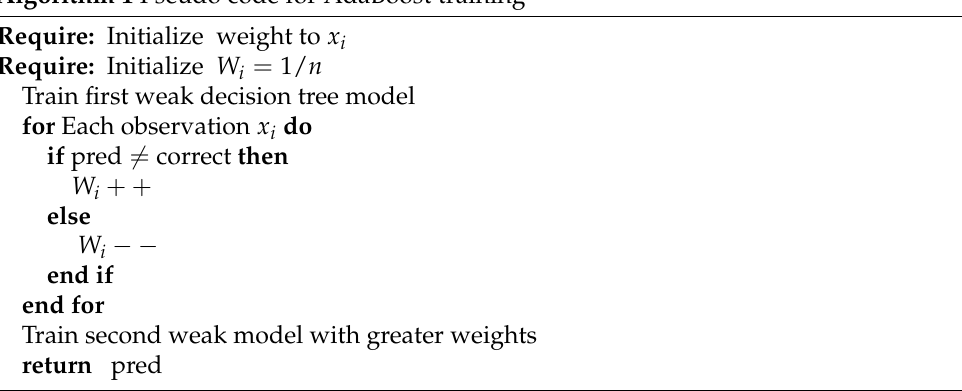
Algorithm 1 Pseudo code for AdaBoost